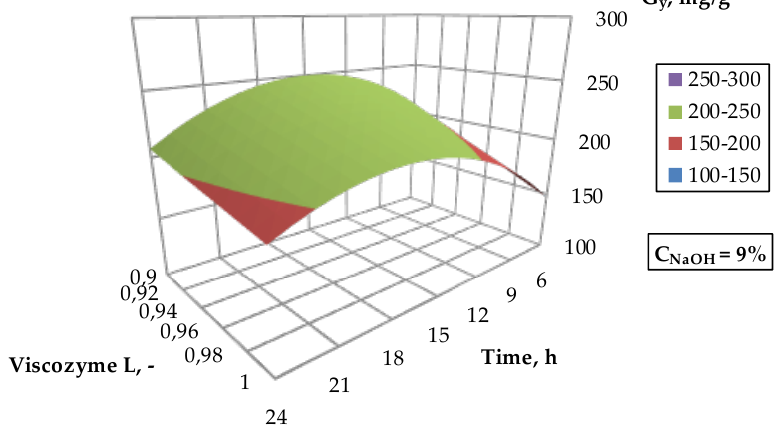
Figure 9. The surface response plots of the effects of Viscozyme L content and hydrolysis time on the glucose yield for NaOH concentration of 9%.